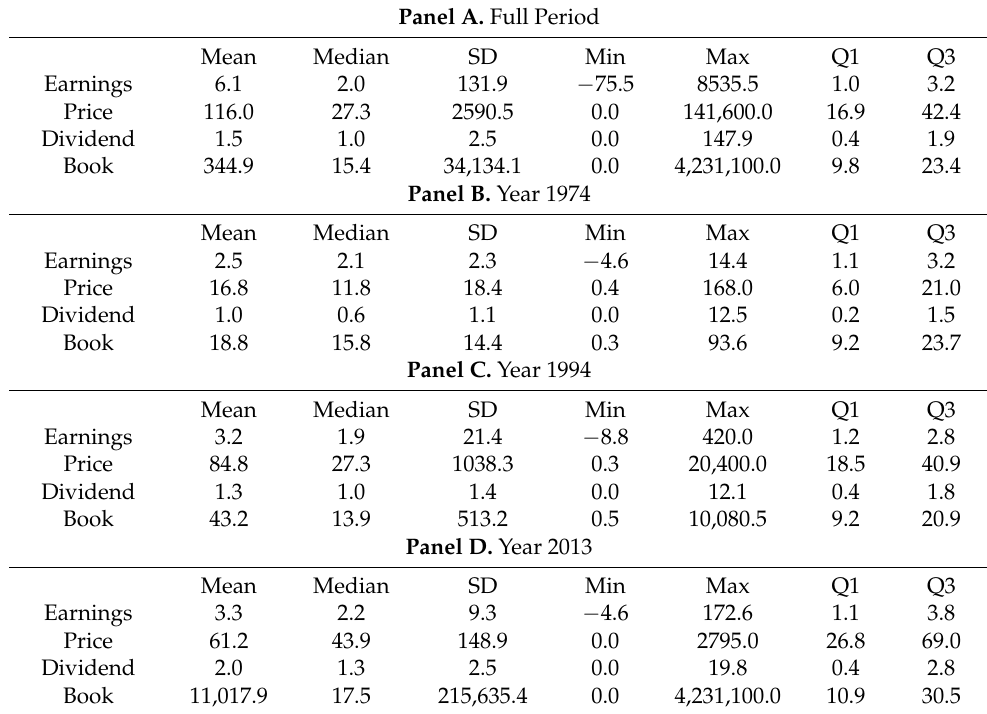
Table 1. Descriptive